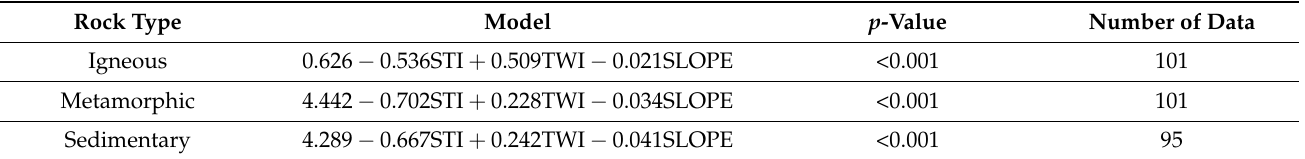
Table 5. The result of soil depth prediction models in this study.